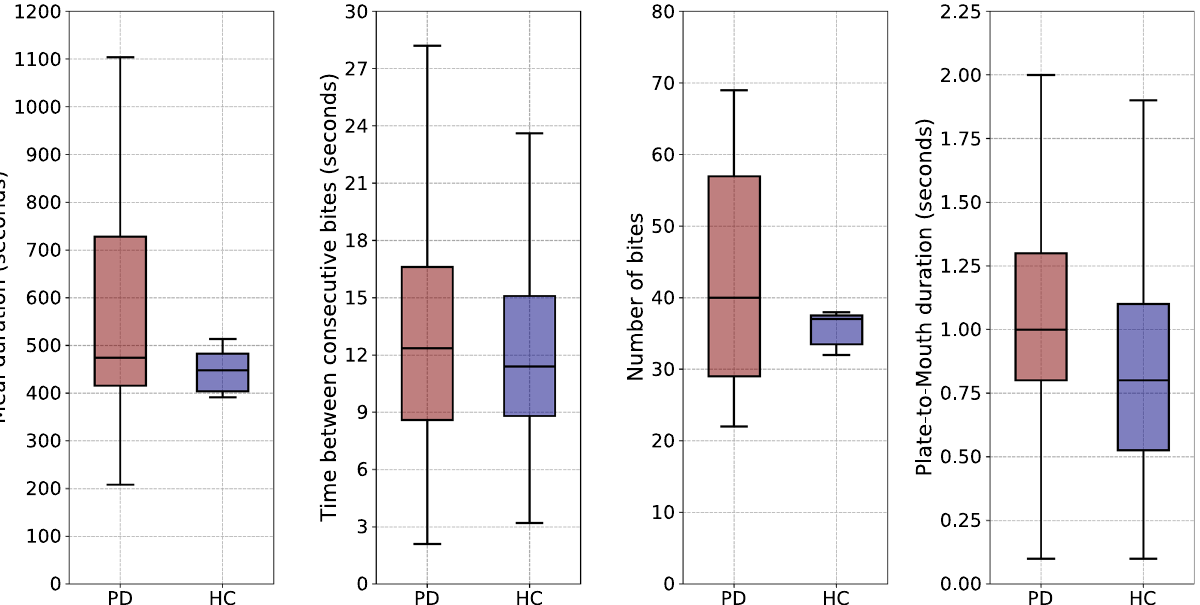
Figure 8. Box plots depicting (from left to right) how: ( i ) the duration of meals, ( ii ) the time between consecutive bites, ( iii ) the number of bites and ( iv ) the PtM durations extracted from all inter-bite intervals, are distributed to the PD and HC populations of the EaC